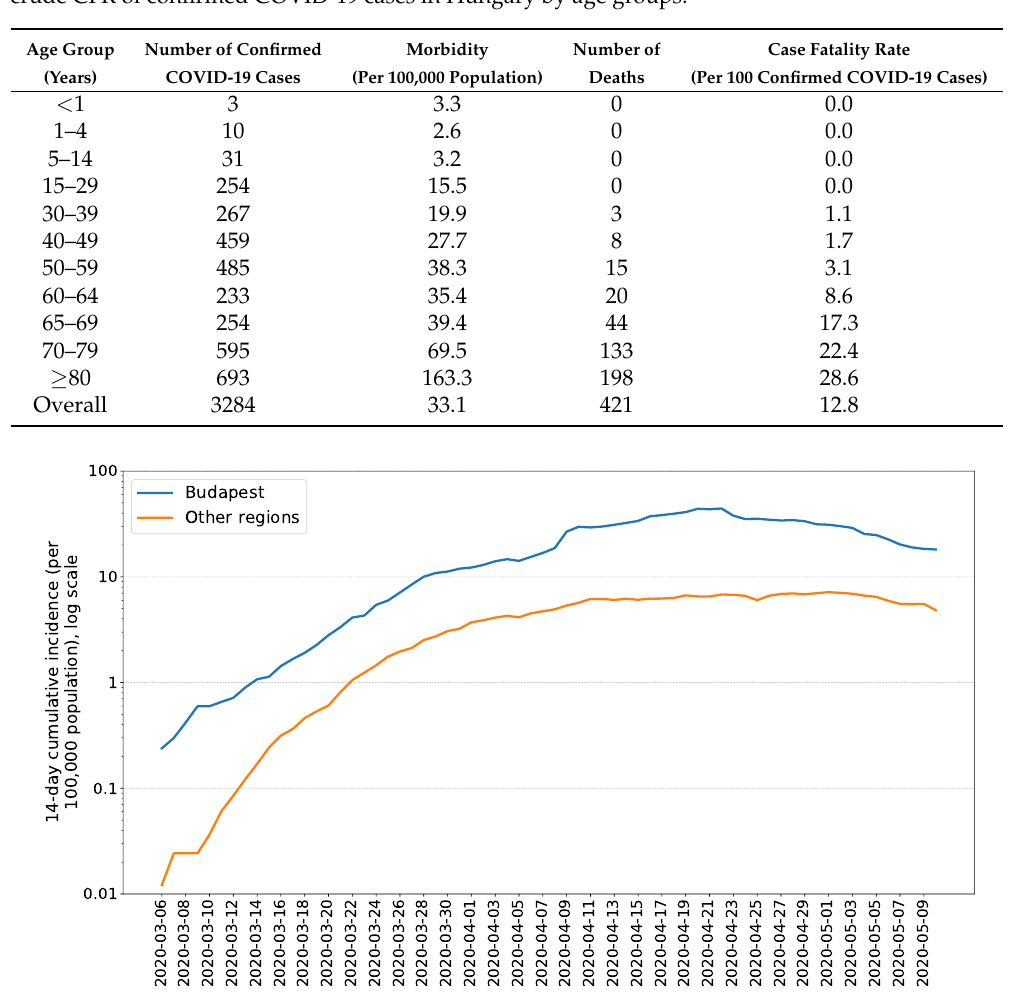
Figure 5. Fourteen-day cumulative incidence of confirmed COVID-19 cases in Budapest and in other regions of Hungary (reported until 10 May 2020. Data source: